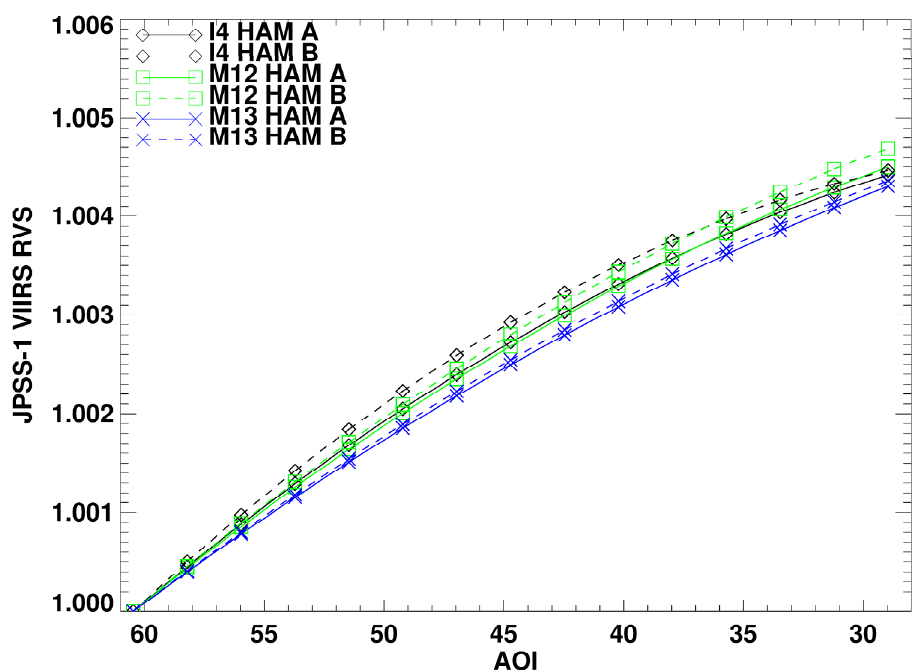
Figure 16. Band-averaged RVS for JPSS-1 VIIRS all TEBs from the SV AOI through to the end of scan AOI for the Mid-wave Wavelength Infrared (MWIR) bands.